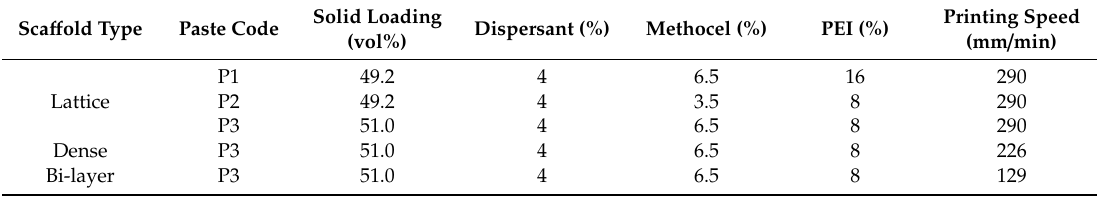
Table 1. Di ff erent paste formulations used for the fabrication of the robocast